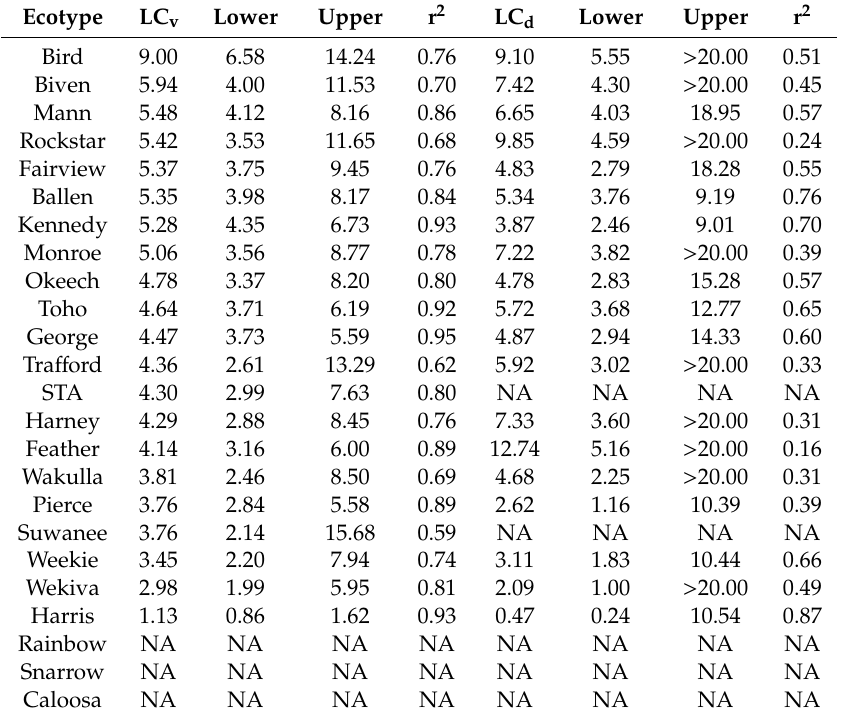
Table 2. Lethal concentration (LC 50 ) of salt expected to cause a 50% reduction in visual rating (LC v ) and dry weight (LC d ) of Vallisneria americana compared with plants grown at 2.0 ppt saline solution (salinity level with the best plant performance). LC 50 , upper and lower 95% confidence interval are calculated based on nonlinear regressions fitted for visual rating and dry weight data. Ecotypes are considered di ff erent if their upper and lower confidence intervals do not